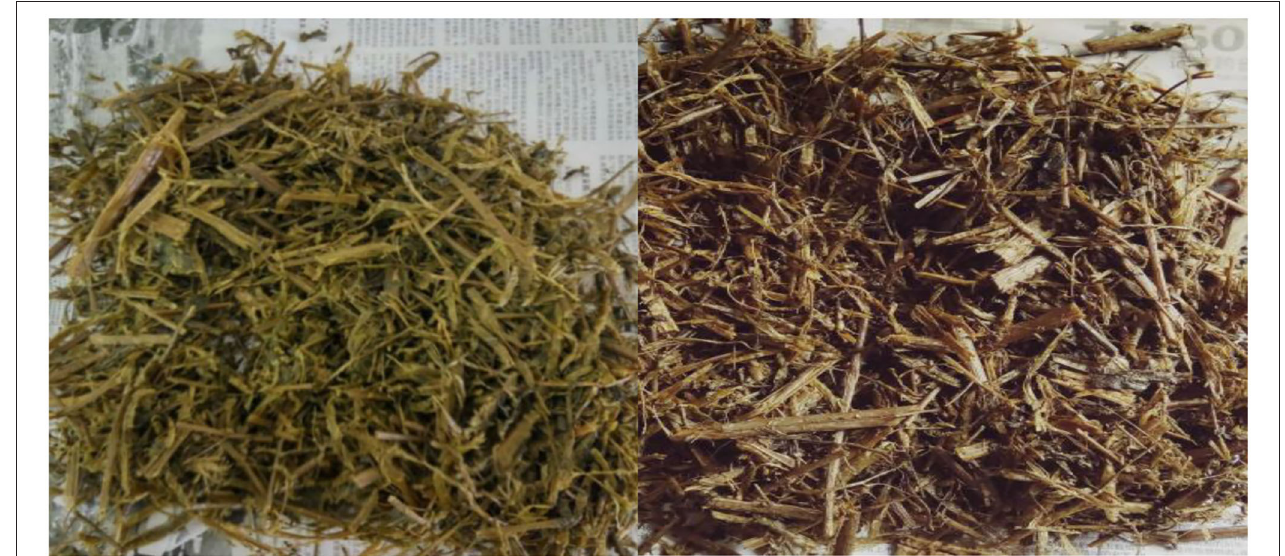
FIGURE 1 | The color of silage rape [ (left) : silage 60 days; (right) : silage 90 days].